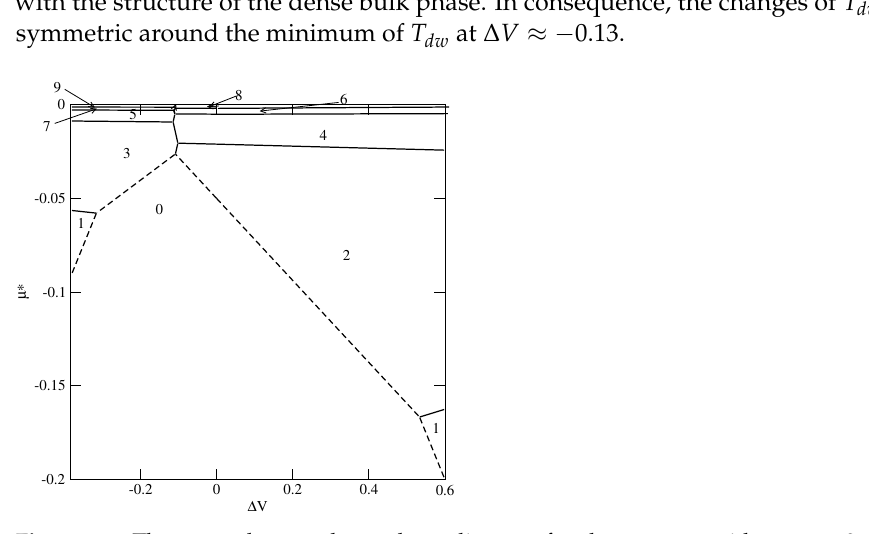
Figure 11. The ground state phase phase diagram for the systems with u AB = 0, u BB = − 0.8, ¯ V = − 0.8. The regions with different film thicknesses (in filled layers) are marked in the figure by numbers.